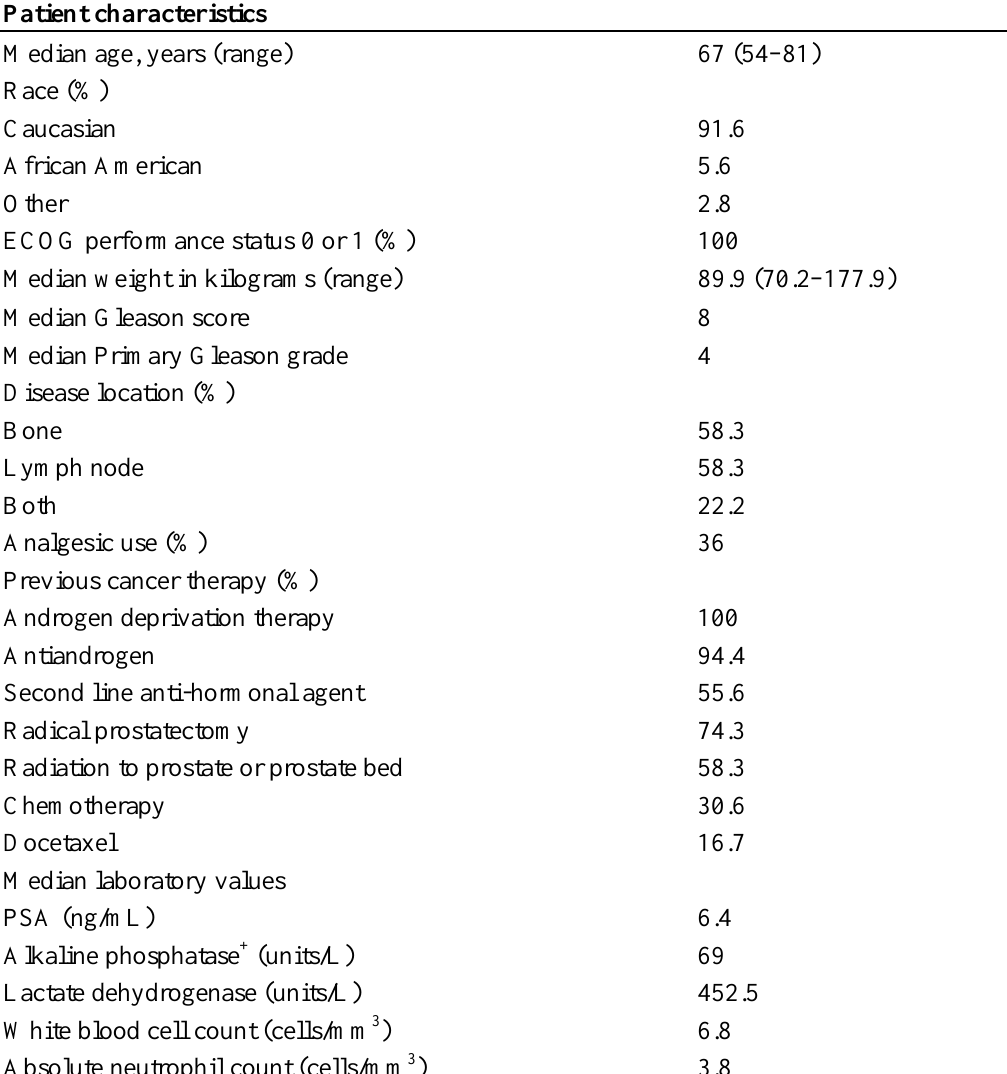
Table 1. Patient baseline characteristics (n =